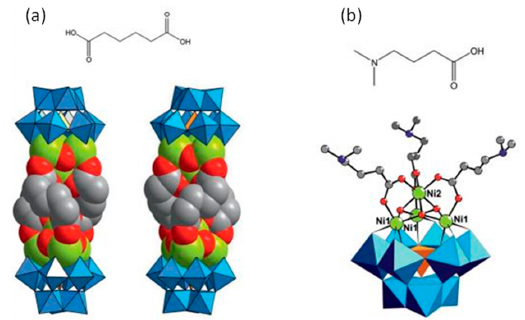
Figure 2. ( a ) Structure of Na 2 K 12 [Ni(H 2 O) 6 ][(SiW 9 O 34 ) 2 (OH) 6 Ni 8 (C 6 H 8 O 4 ) 3 ] · 40H 2 O hybrid with adipic acid as ligand; ( b ) structure of Na 1 . 5 K 2 . 5 [Ni(H 2 O) 6 ] 0 . 5 (SiW 9 O 34 ) (OH) 3 Ni 4 (C 6 H 13 NO 2 ) 3 ]·17H 2 O hybrid with dimethylaminobutiric acid as ligand [96]. Table 1. Summary of inorganic–organic hybrids based on TMSPs with N-/O-donor ligands. Compound LPOM Metal Ligand Ref.